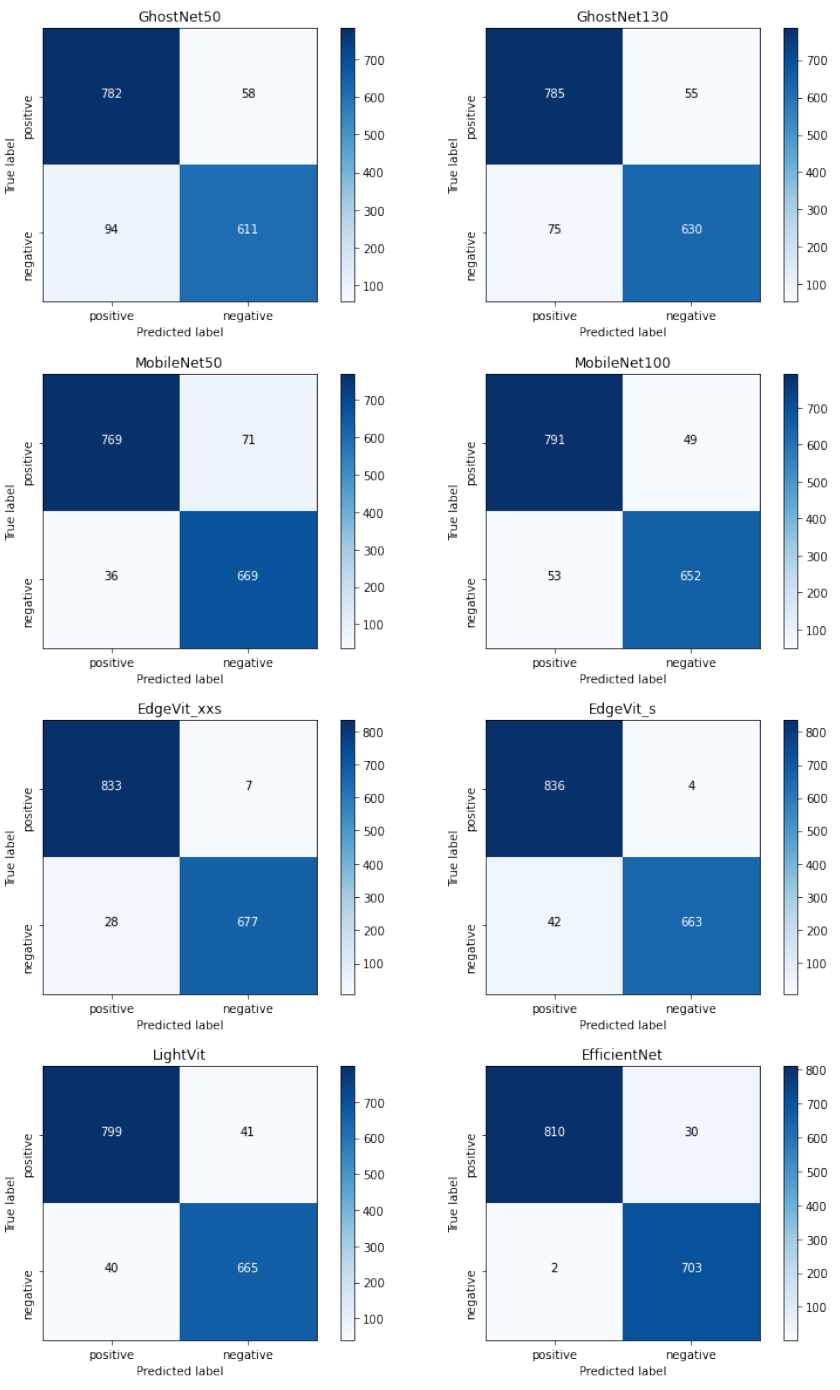
Figure 10. Confusion matrices of the